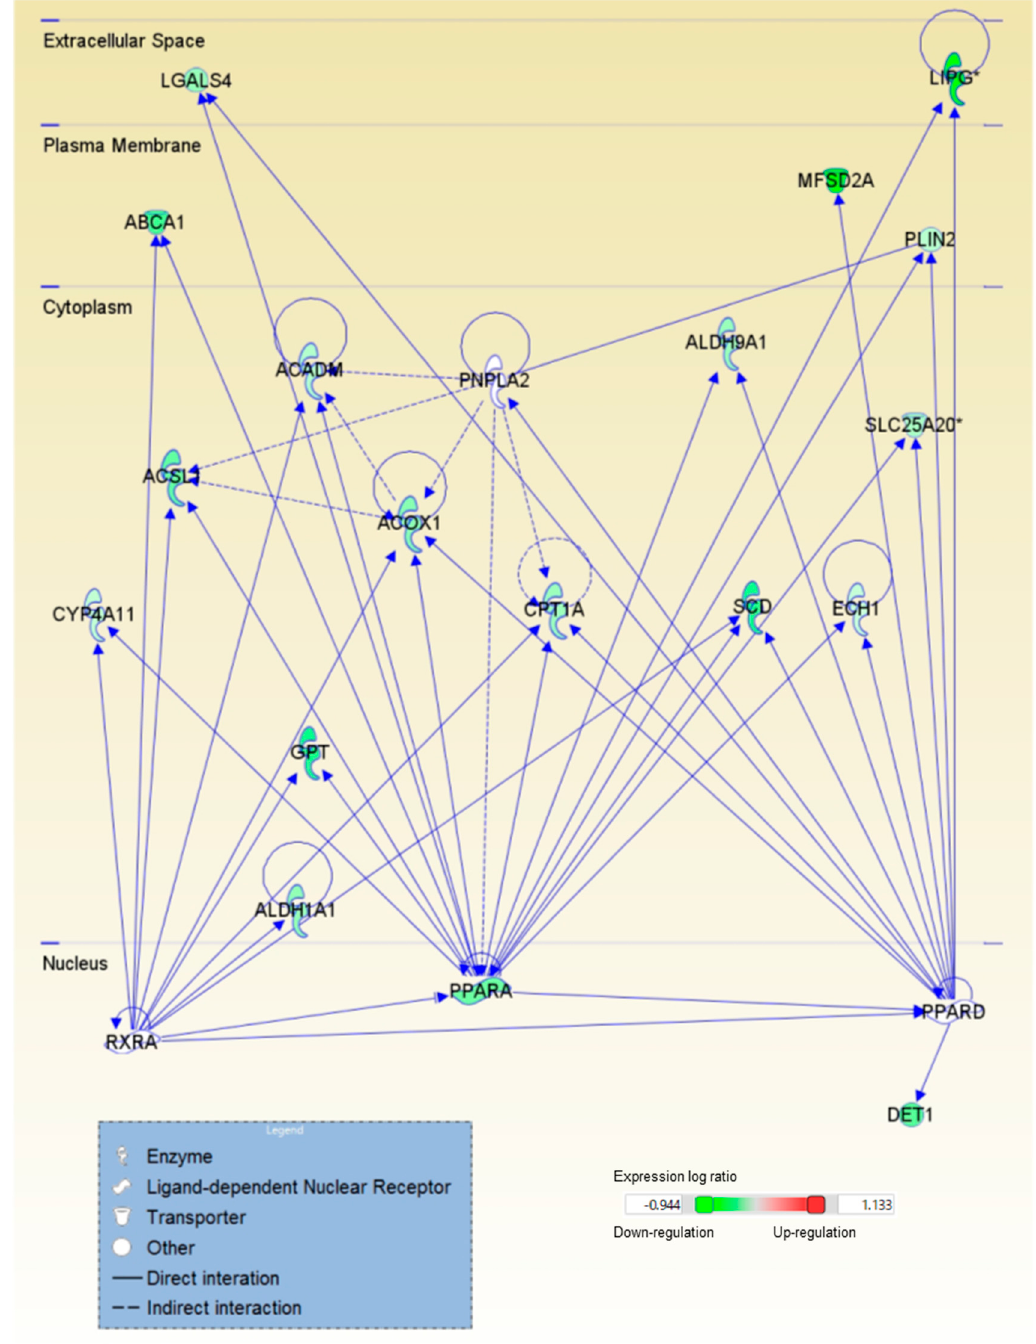
Figure 5. Relationship among PNPLA2, PPARD, PPARA, and RXRA and the target molecules of PNPLA2, PPARD, and RXRA in the dataset regulated by astaxanthin in mice with nonalcoholic steatohepatitis. → , expression: —, protein-protein binding. *, More than 2 genes were included. The network of the molecules was identified by Ingenuity Pathway Analysis.